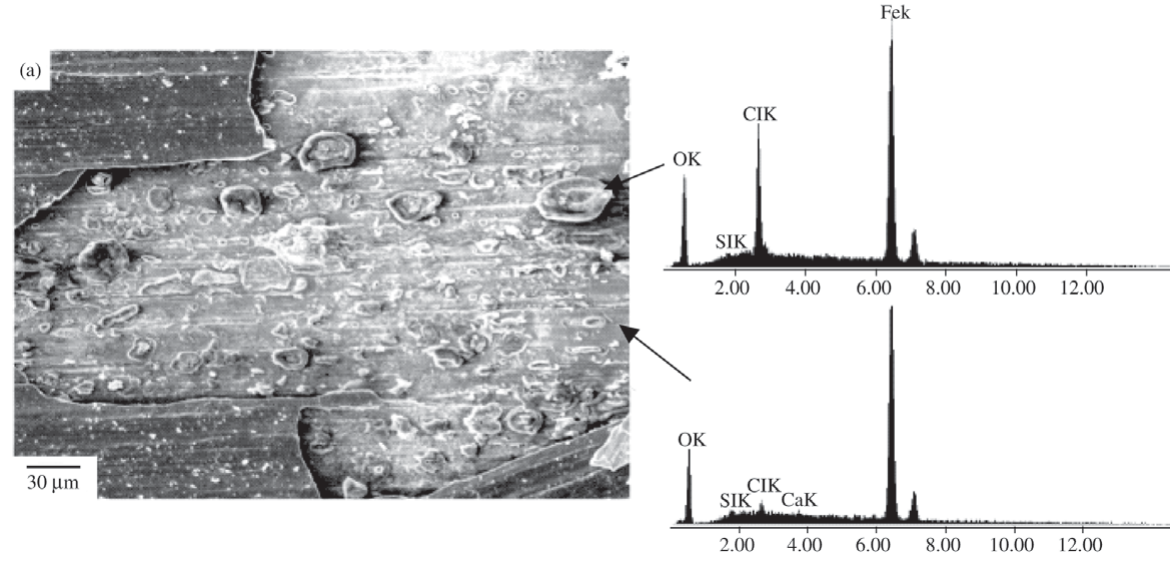
Figure 9. SEM micrograph of the top surface (near 0°) on a specimen tested at 400 °C for 24 h with 50 ppm HCl. EDS analyses show compositions of the nodule and the thin oxide on the alloy